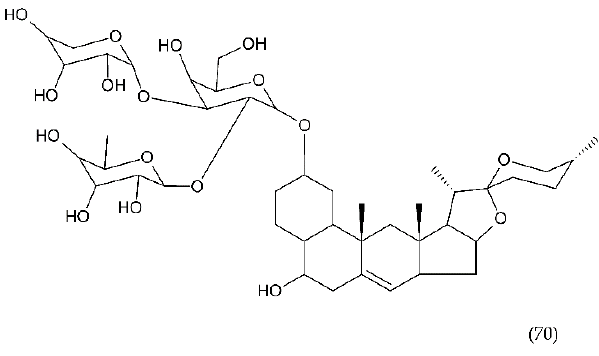
Figure 20. Chemical structure of saponin D39 (70).